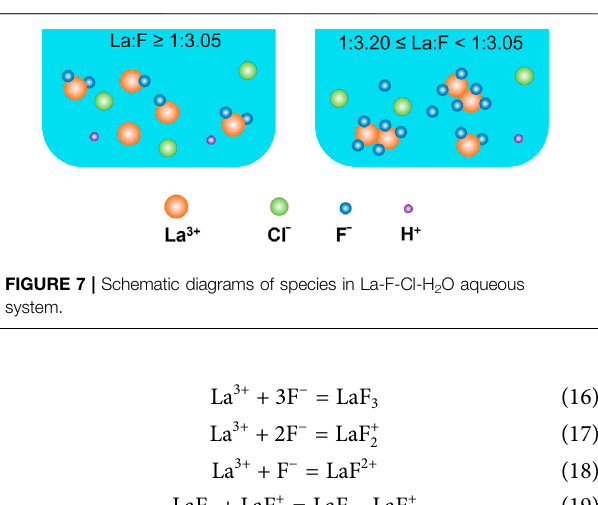
FIGURE6| Distributionof fl uorineelementinsolutionswithdifferentLa/F molar ratios ( ≤ 1:3.00).